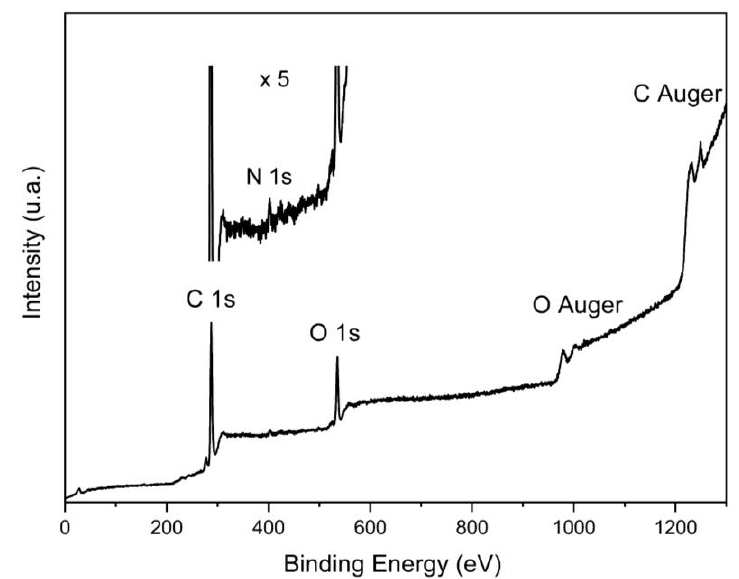
Figure 3. XPS survey of the hydrochar obtained from orange juice, where the presence of carbon and oxygen with traces of nitrogen is evident. The inset shows a magnification of the region containing the N 1s peak on the same energy scale of the complete spectrum.